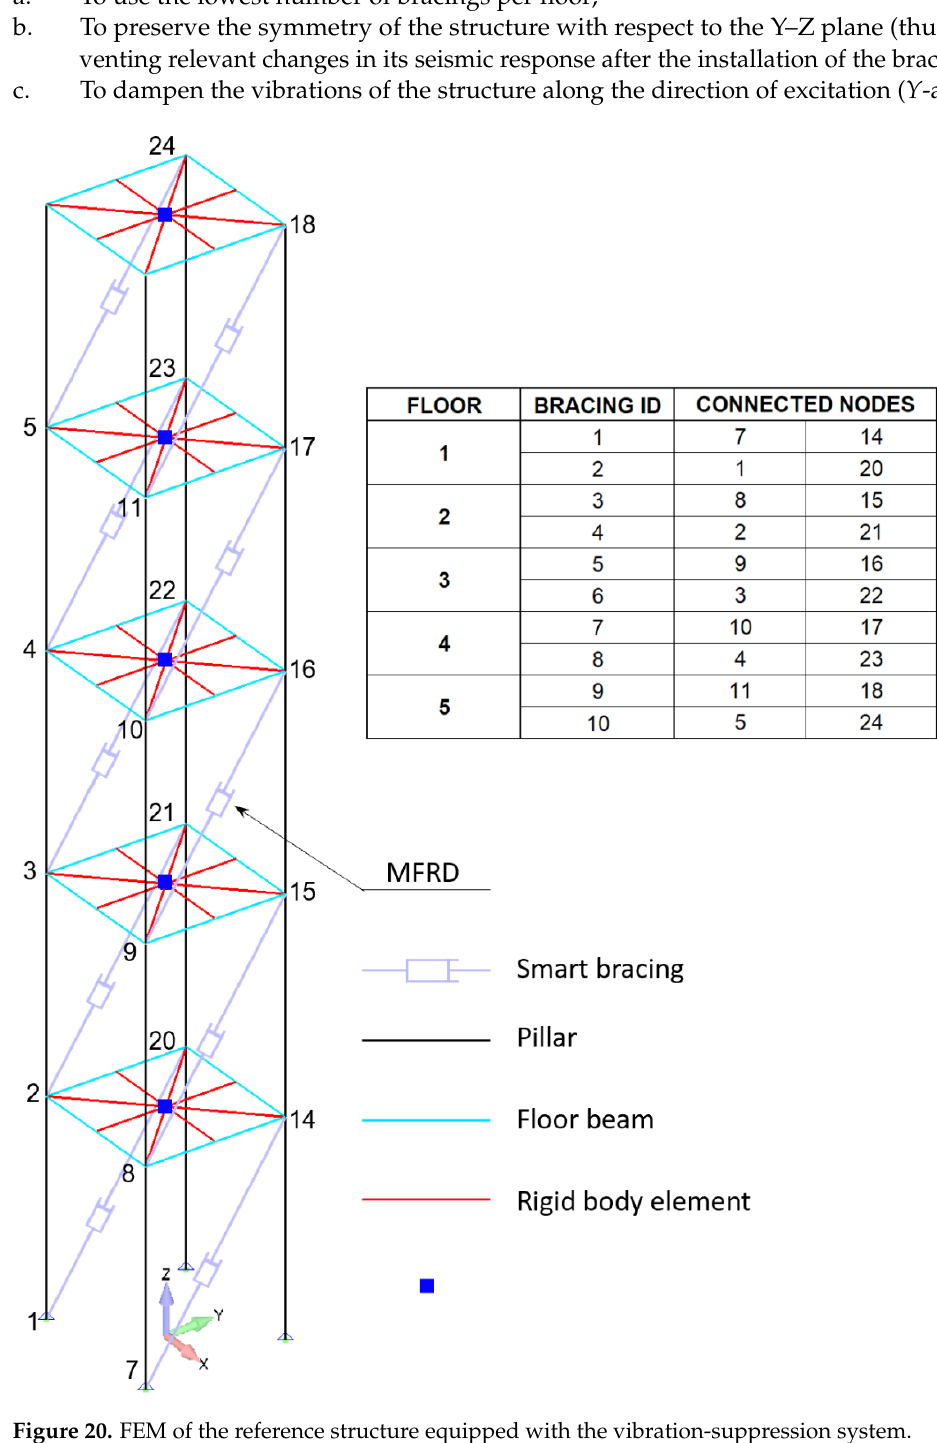
Figure 20. FEM of the reference structure equipped with the vibration-suppression system.